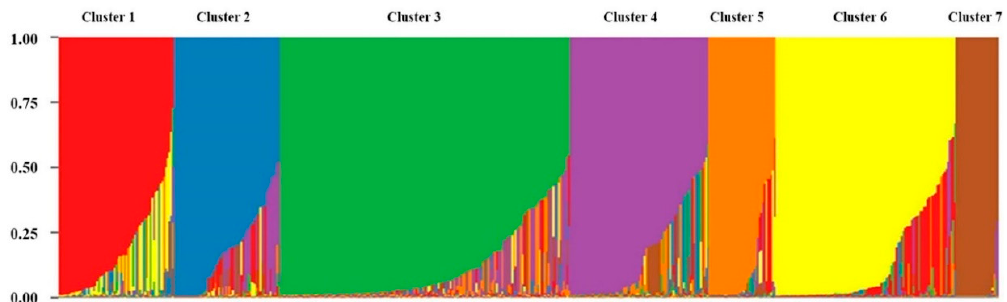
Figure 3. Inference of number of clusters in rice germplasm collection based on 16 SSR markers using STRUCTURE program. The Bayesian model in the STRUCTURE v2.3.4 program was used to test K (number of clusters) using the parameter of burn-in/Markov chain Monte Carlo (MCMC): 100,000/250,000 iterations. An ad hoc quantity ( Δ K) [31] was calculated for each K to detect the best number of clusters (K = 7).